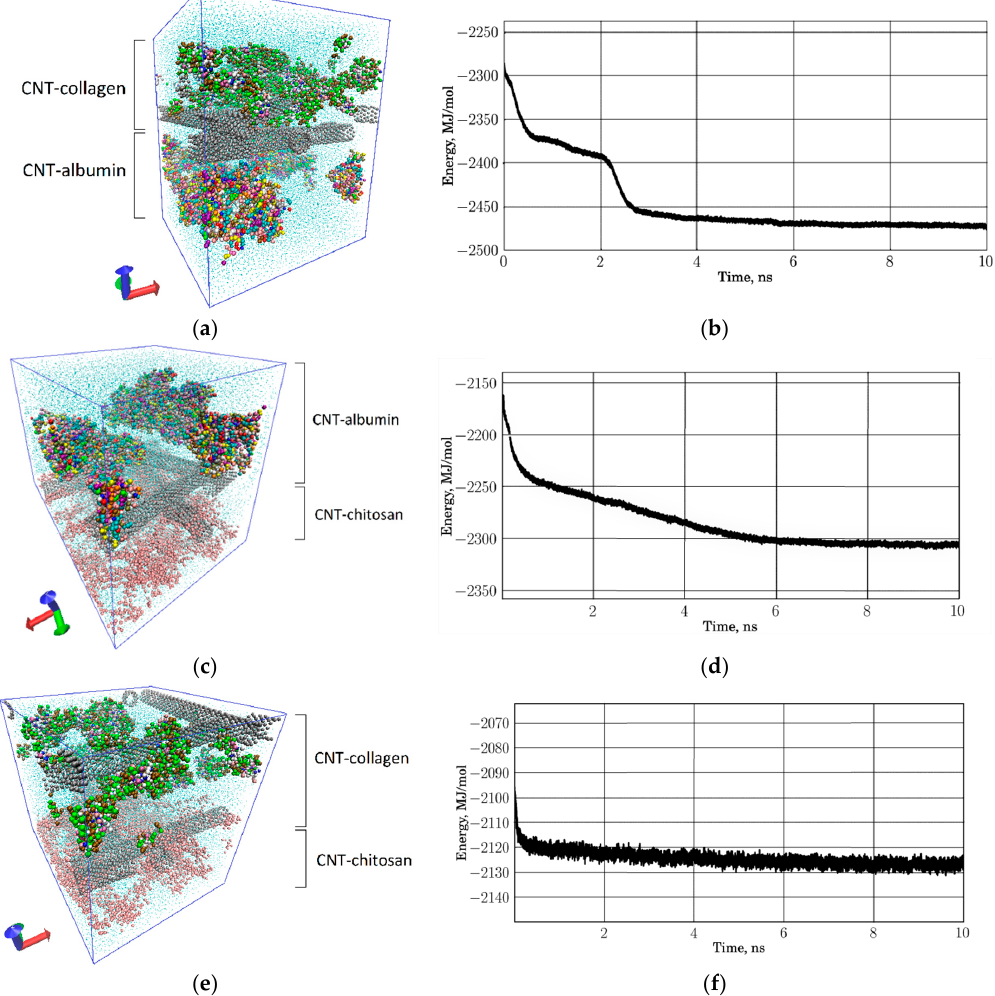
Figure 5. Layered 2D protein-polymer matrices: Coarse-grained model ( a ) and energy of albumin– collagen structure ( b ); coarse-grained model ( c ) and energy of albumin–chitosan structure ( d ); coarse-grained model ( e ) and energy of collagen–chitosan structure ( f